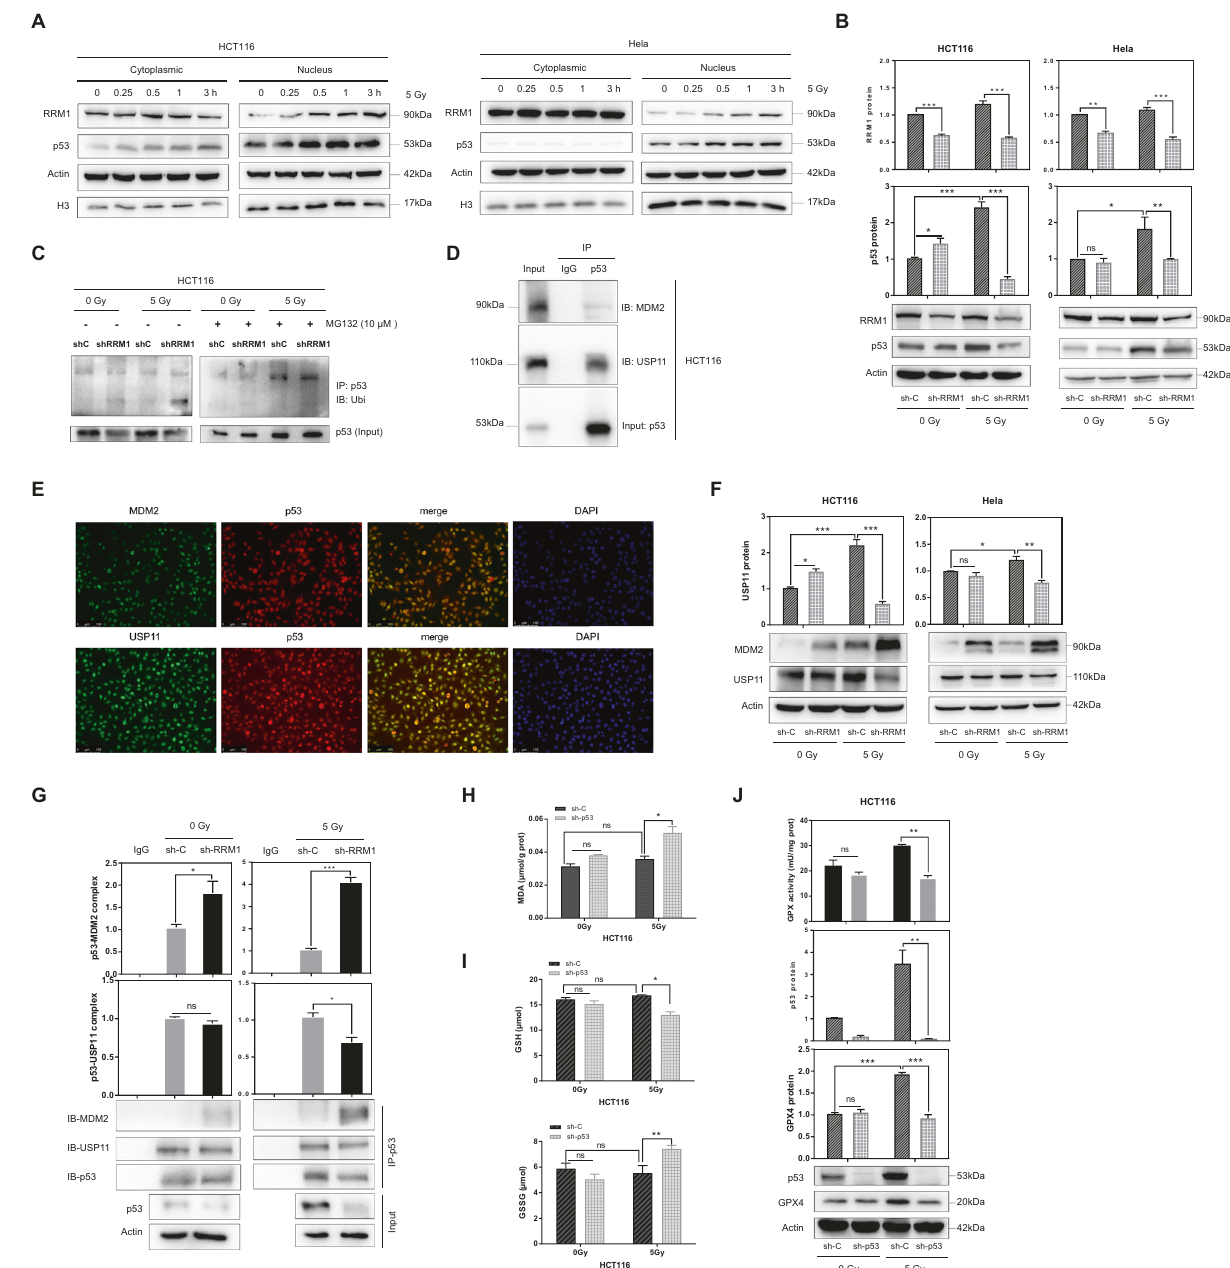
Fig. 3 RRM1 regulates the ubiquitination of p53. A Cells were treated with 5 Gy γ -ray for nucleocytoplasmic separation at different time points. B The expression level of p53 was detected in RRM1 knockdown cells after 5 Gy γ -ray. C Cells were treated with MG132, p53 was immunoprecipitated with anti-p53 antibody and immunoblotted with anti-ubiquitin antibody. D , E Co-IP ( D ) or immuno fl uorescence ( E ) were used to detect the interaction ( D ) or co-localization (E) of endogenous p53 and endogenous MDM2 or USP11 in HCT116 cells ( D ) or Hela cells ( E ). F Expression levels of MDM2 and USP11 proteins in RRM1 knockdown cells after 5 Gy γ -ray. G Analysis of the binding between p53 and MDM2 or USP11 in control and RRM1 knockdown cells by immunoprecipitation and immunoblotting. H , I MDA ( H ) and GSH and GSSG levels ( I ) were detected in p53-de fi cient cells after radiation. J Lower GPX activity and GPX4 expression were detected in RRM1 knockdown cells after 5 Gy γ apoptotic protein expression (cleaved caspase-3, cleaved caspase- 7, and cleaved caspase-9) were detected in RRM1-knockdown cells after radiation (Fig. 6C). Notably, the expression of puma protein was also signi fi cantly increased (Fig. 6C). Furthermore, RRM1 knockdown signi fi cantly promoted the expression of γ H2AX protein, a marker of DNA damage upon radiation (Fig. 6D, E). The above results indicate that the downregulation of RRM1 promotes radiation-induced apoptotic signaling.